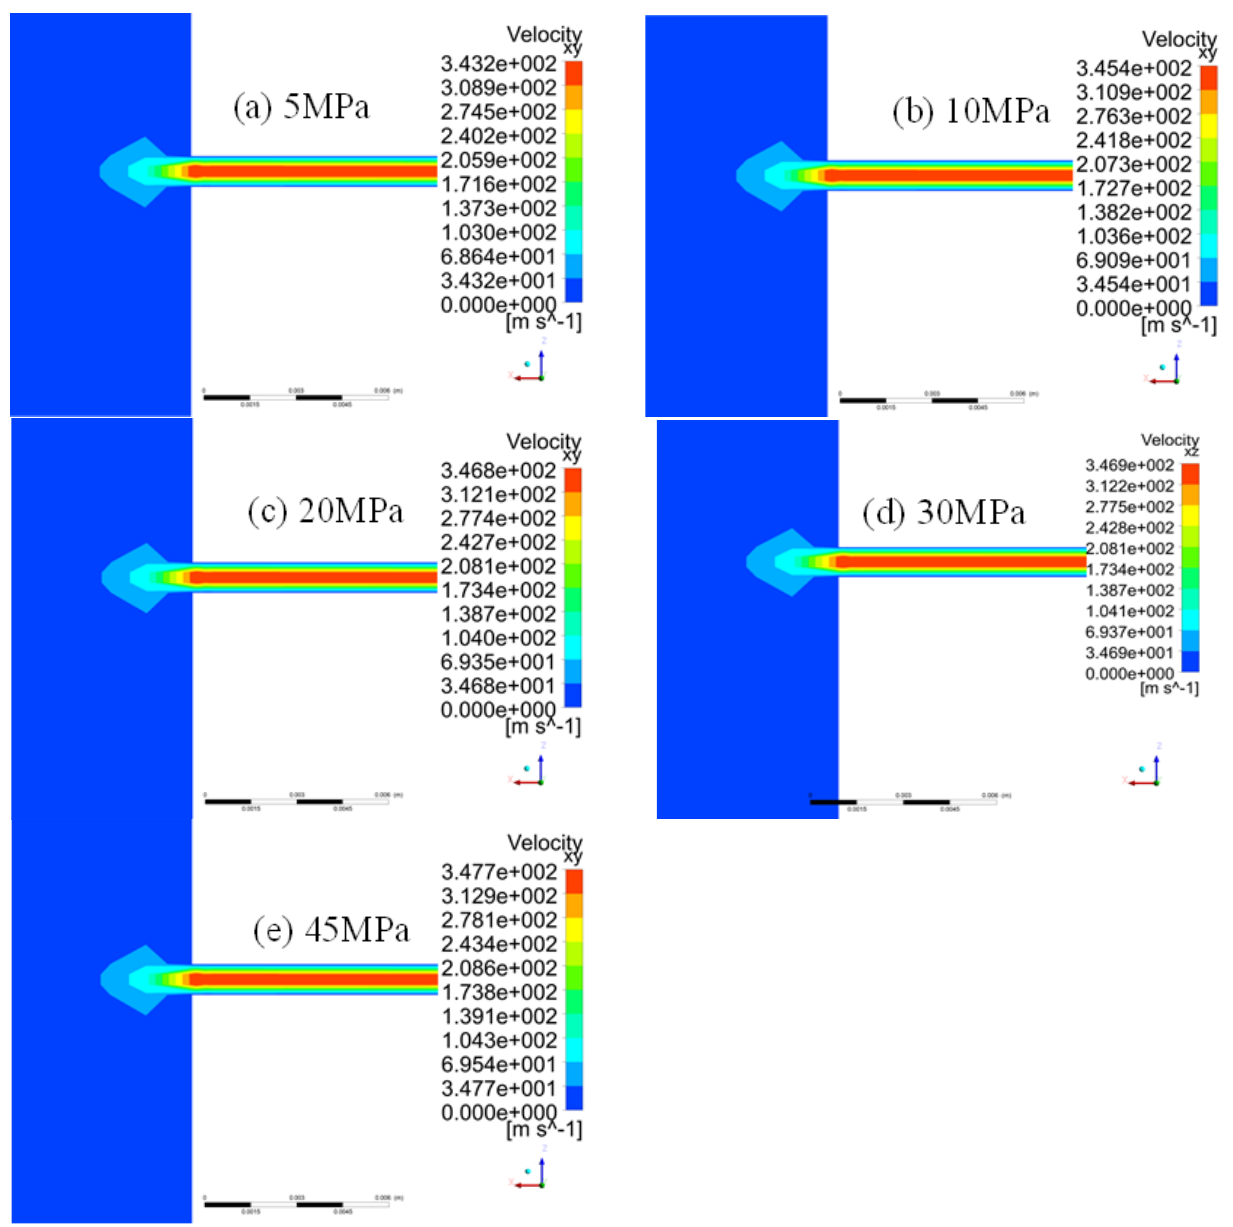
Figure 6. Flow field distribution of a square leakage hole with a side length of 0.4 mm under different inner-outer pressure differences.